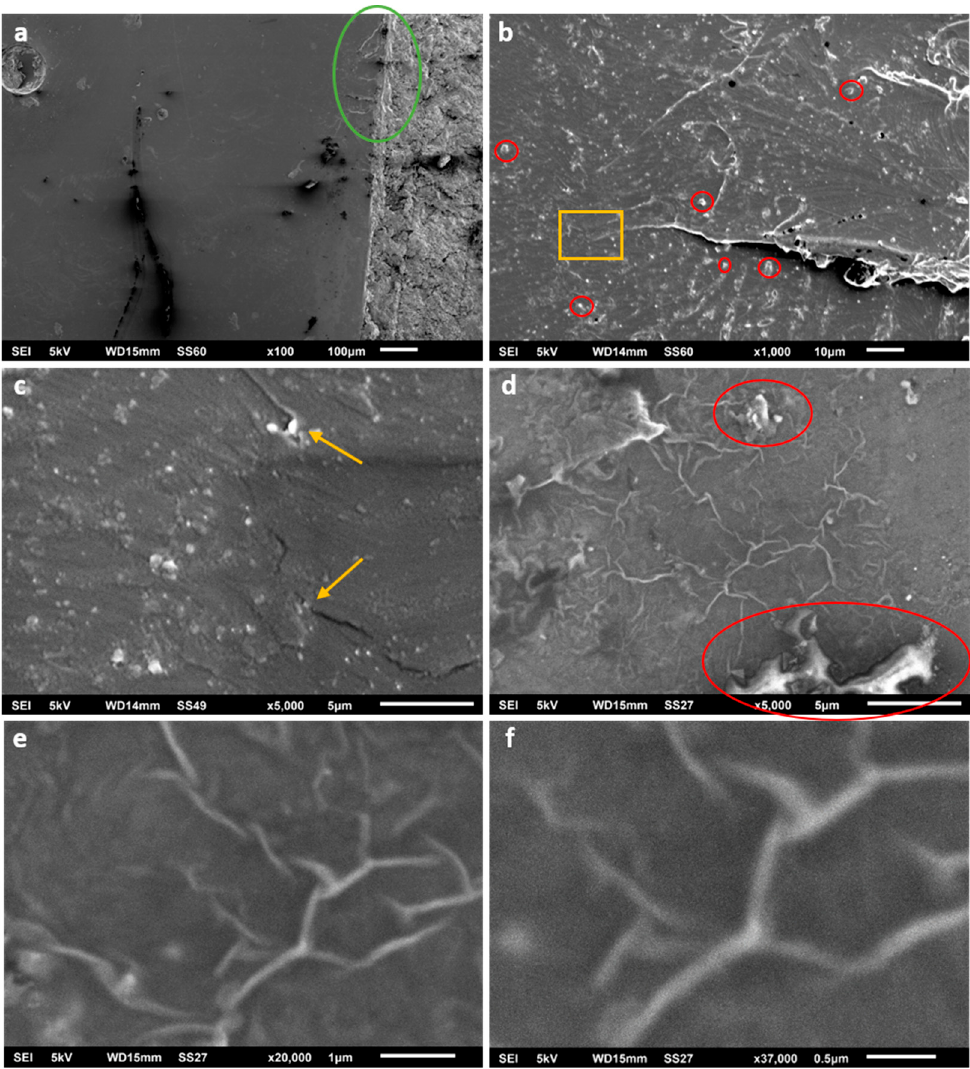
Figure 6. Scanning electron micrographs recorded from the fracture surface of a CNTs0.5-III SENB specimen at ( a ) ×100, ( b ) ×1000, ( c ) and ( d ) ×5000, ( e ) ×20,000, and ( f ) ×37,000 magnification.